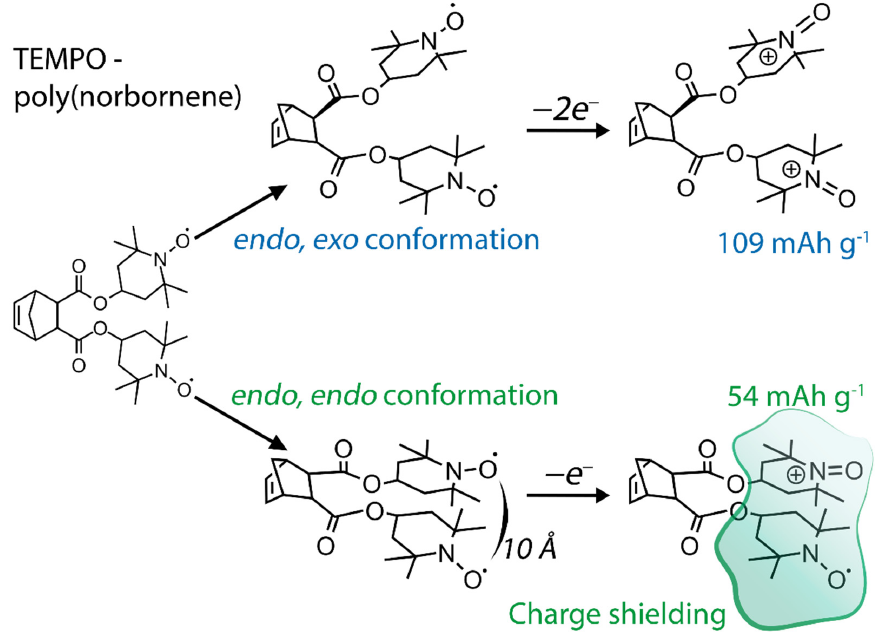
Figure 5. Schematic illustration of influence of neighboring TEMPO groups on molecule oxidation.